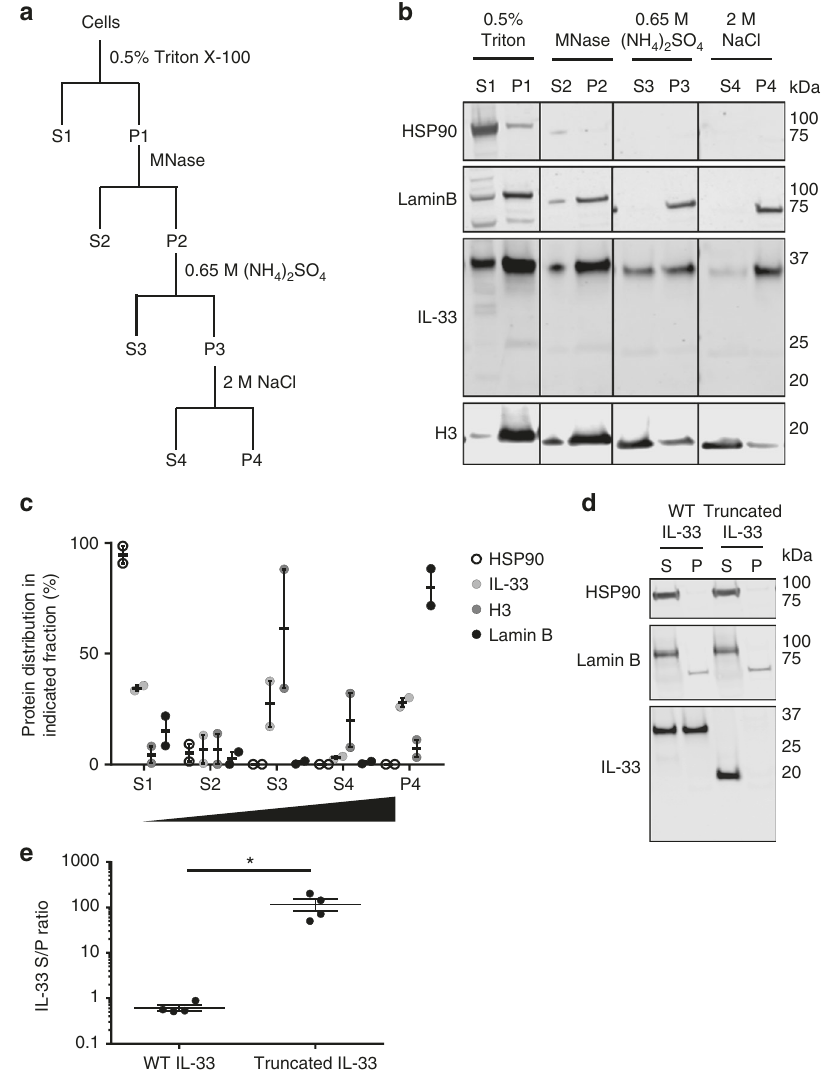
Fig. 2 IL-33 tightly associates with chromatin. a Schematic of biochemical fractionation of IL-33-overexpressing TE-7 cells with serial extraction with indicated treatments. b Representative western blot with quantitation of two independent experiments in c . S refers to proteins extracted with each serial treatment, and P represents unextracted proteins remaining in the residual pellet. Graph in c depicts the percentage of a protein ’ s distribution in an indicated fraction compared to the total (S1 + S2 + S3 + S4 + P4). d , e Pools of TE-7 cells with Dox-inducible overexpression of wild-type or truncated